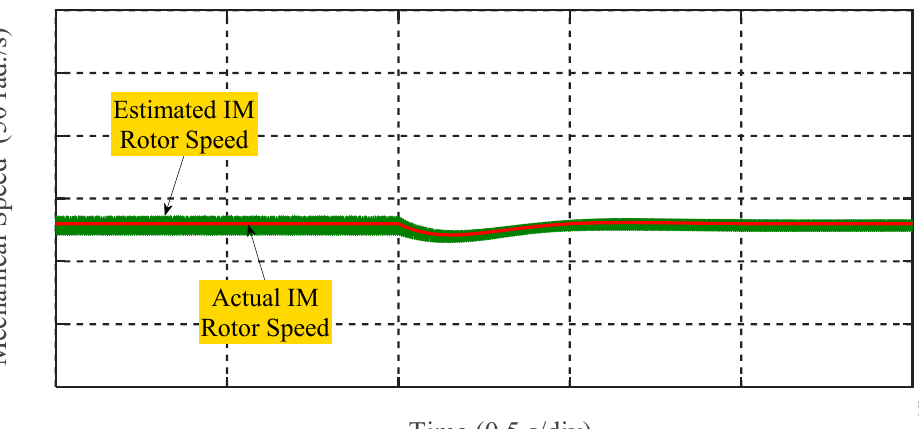
Figure 21. Experimental validation of the proposed sensorless system for IM drives under the start-up condition.